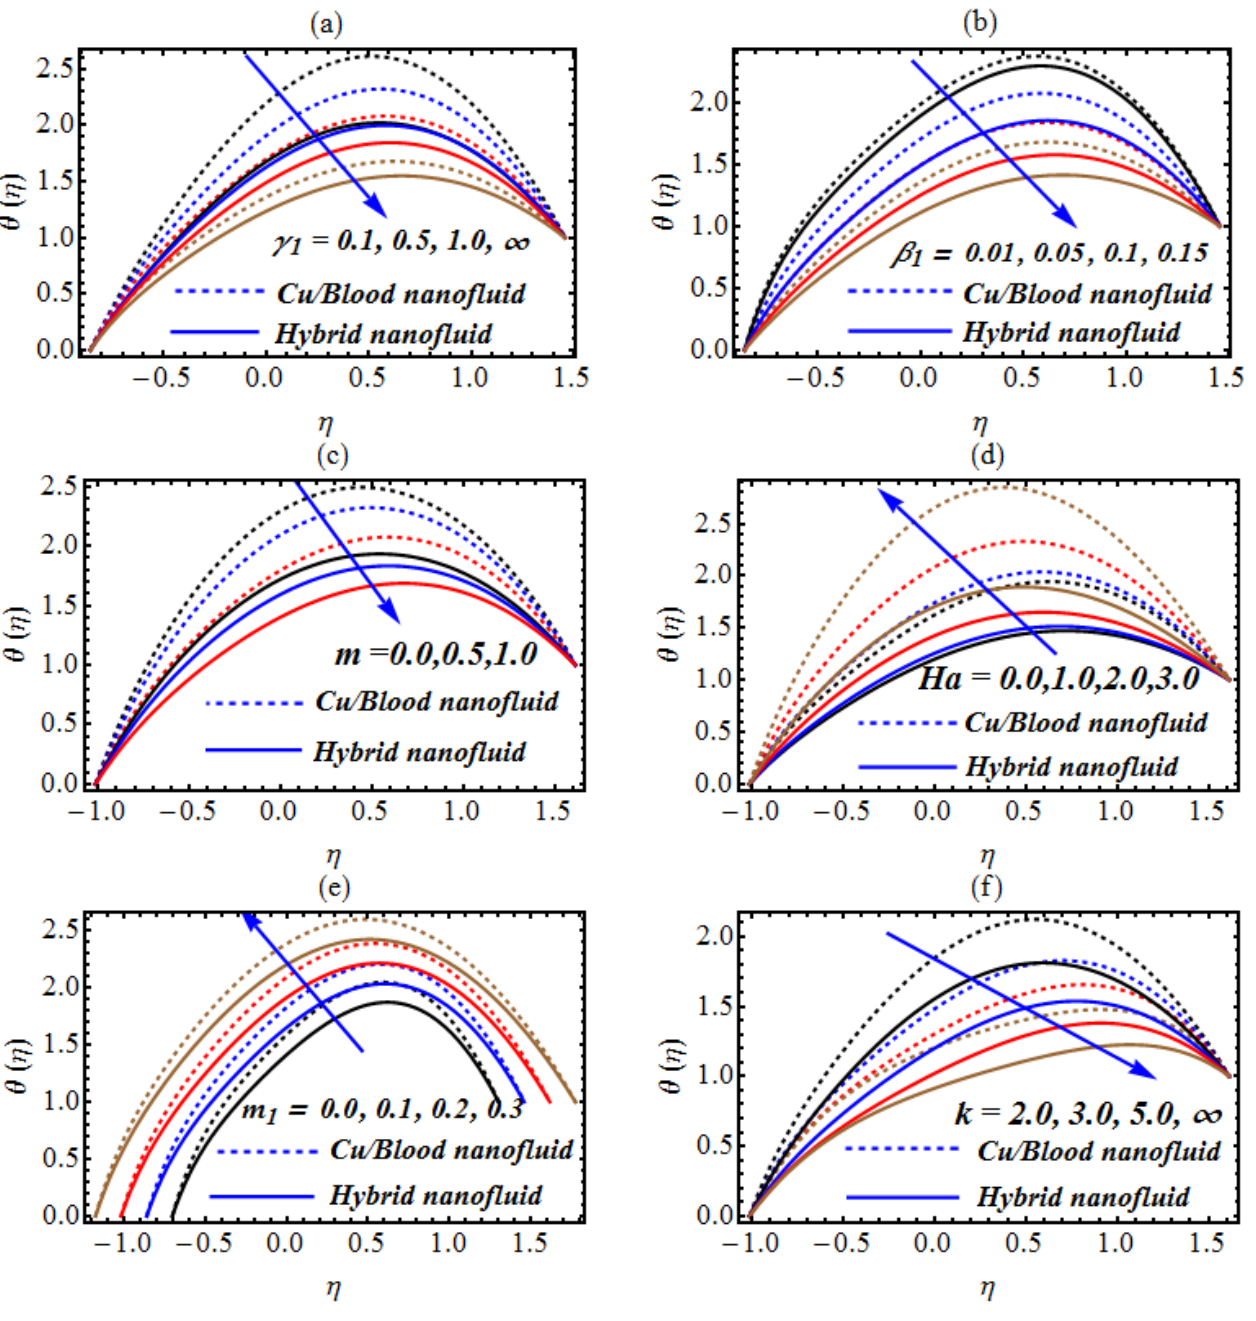
Figure 3. ( a – f ): ( a ) Change in θ for γ 1 ( b ) change in θ for β 1 , ( c ) change in θ for m , ( d ) change in θ for Ha , ( e ) change in θ for m 1 and ( f ) change in θ for k